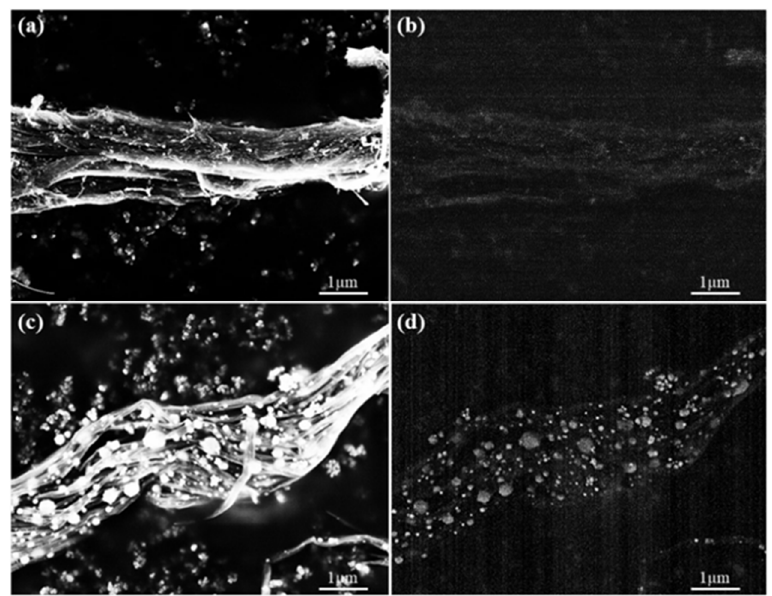
Figure 12. SEM imaging of CNT pulp: ( a ) SE image, ( b ) BSE image of untreated CNT pulp; ( c ) SE image, ( d ) BSE of Eu:Y 2 O 3 -CNT CNT pulp.